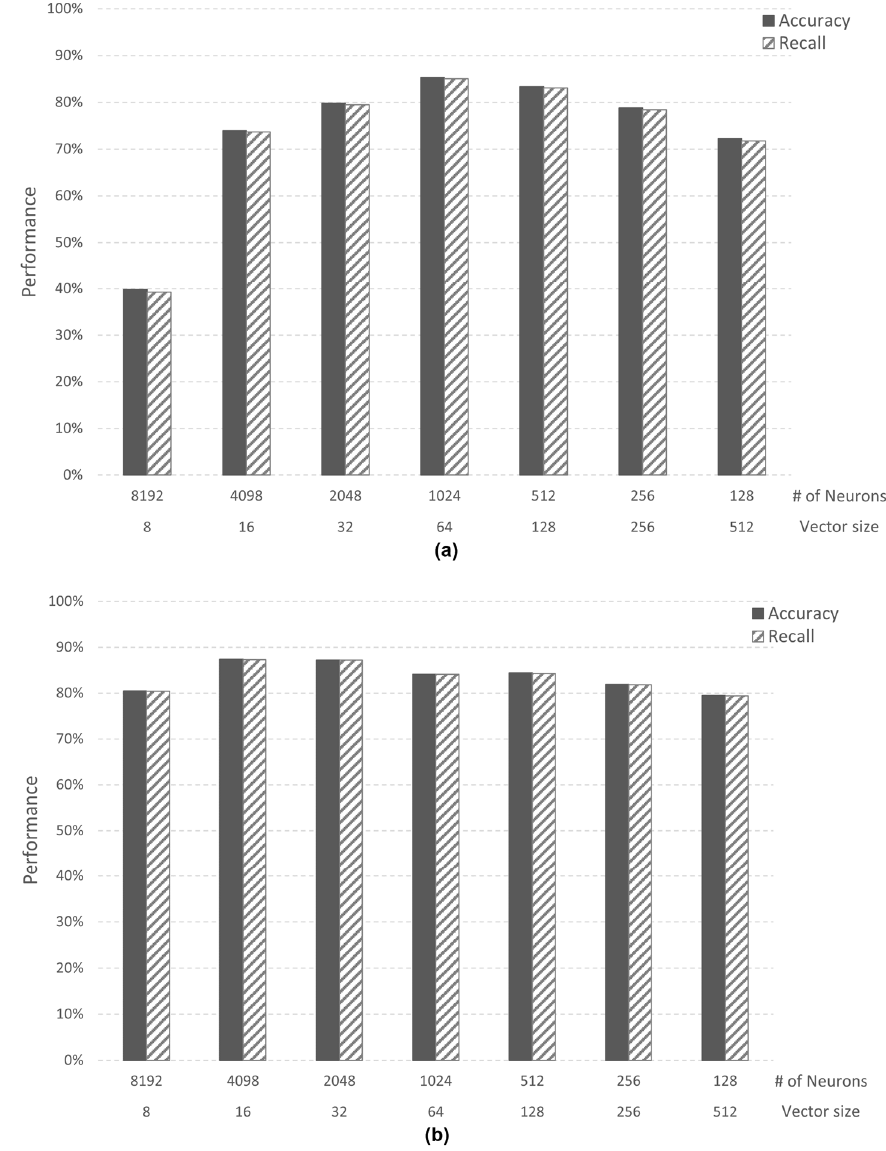
Figure 8. ( a ) Case 1 performance of recognition; ( b ) Case 2–1 performance of recognition.